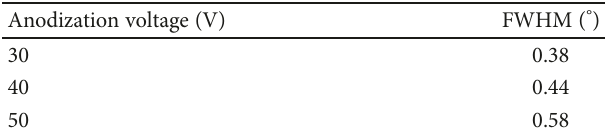
Table 1: FWHM of XRD peak (101) at di ff erent anodization voltages. Samples were anodized at room temperature and annealed at 450 °